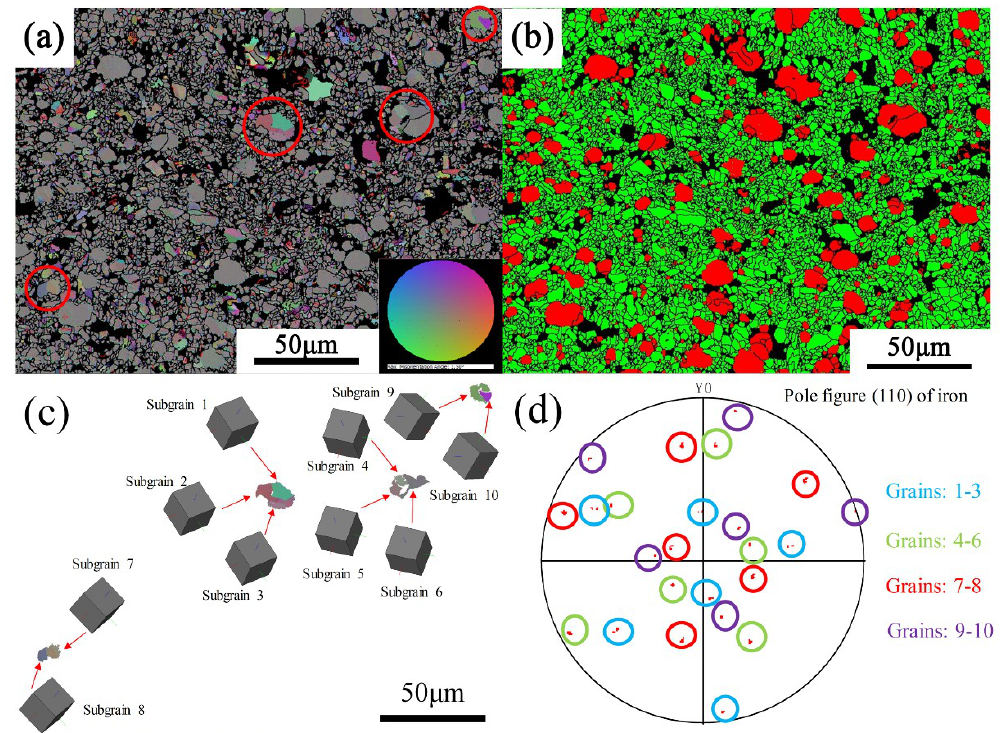
Figure 11. The orientation relationship of subgrains in sample B3. ( a ) low-angle grain boundaries distribution; ( b ) phase distribution; ( c ) orientation relationship of subgrains; ( d ) subgrains plotted in (110).